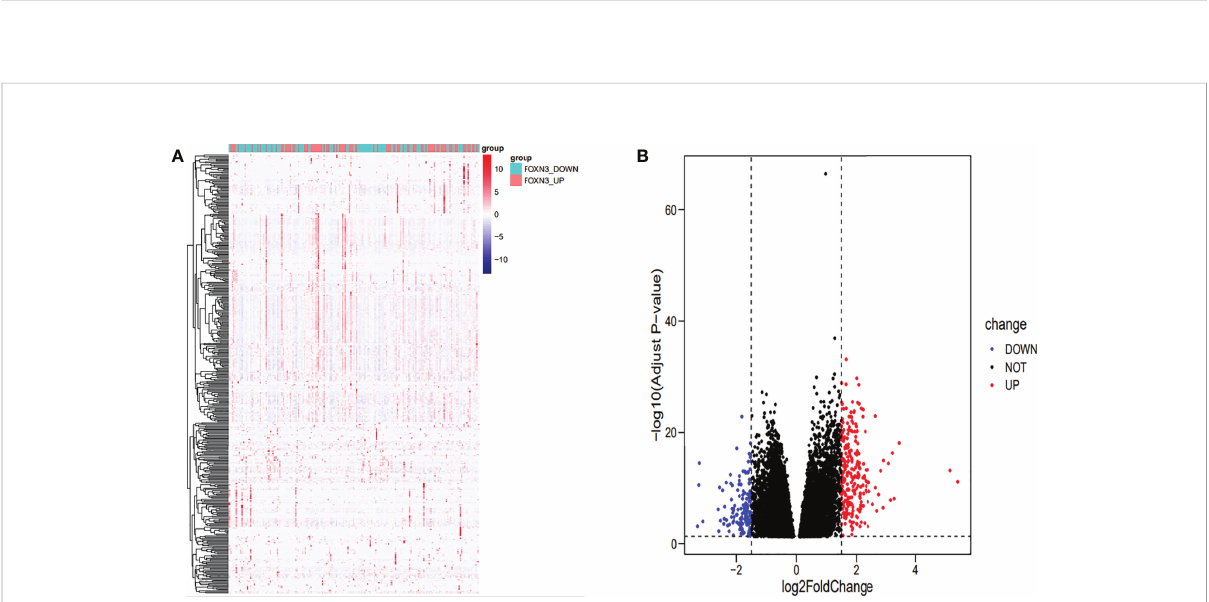
FIGURE 5 (A) Heat map of DEGs when FOXN3 is down-regulated and up-regulated in PDAC based on TCGA database. (B) Volcanic map of differential gene